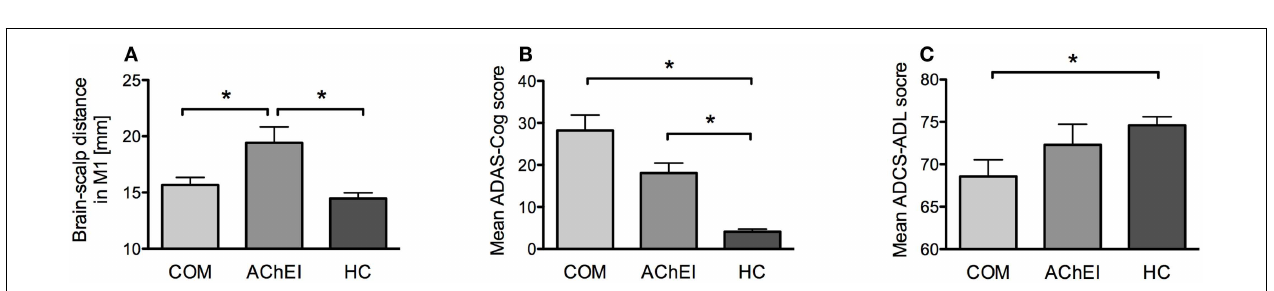
FIGURE 3 | Morphometric, neuropsychological, and behavioral measures ofAChEI, COM, and HC . (A) Brain atrophy as indicated by brain-scalp distances obtained from seven different brain areas (mean ± SE). (B) ADAS-Cog scores (mean ± SE). (C) ADCS-ADL scores (mean ±